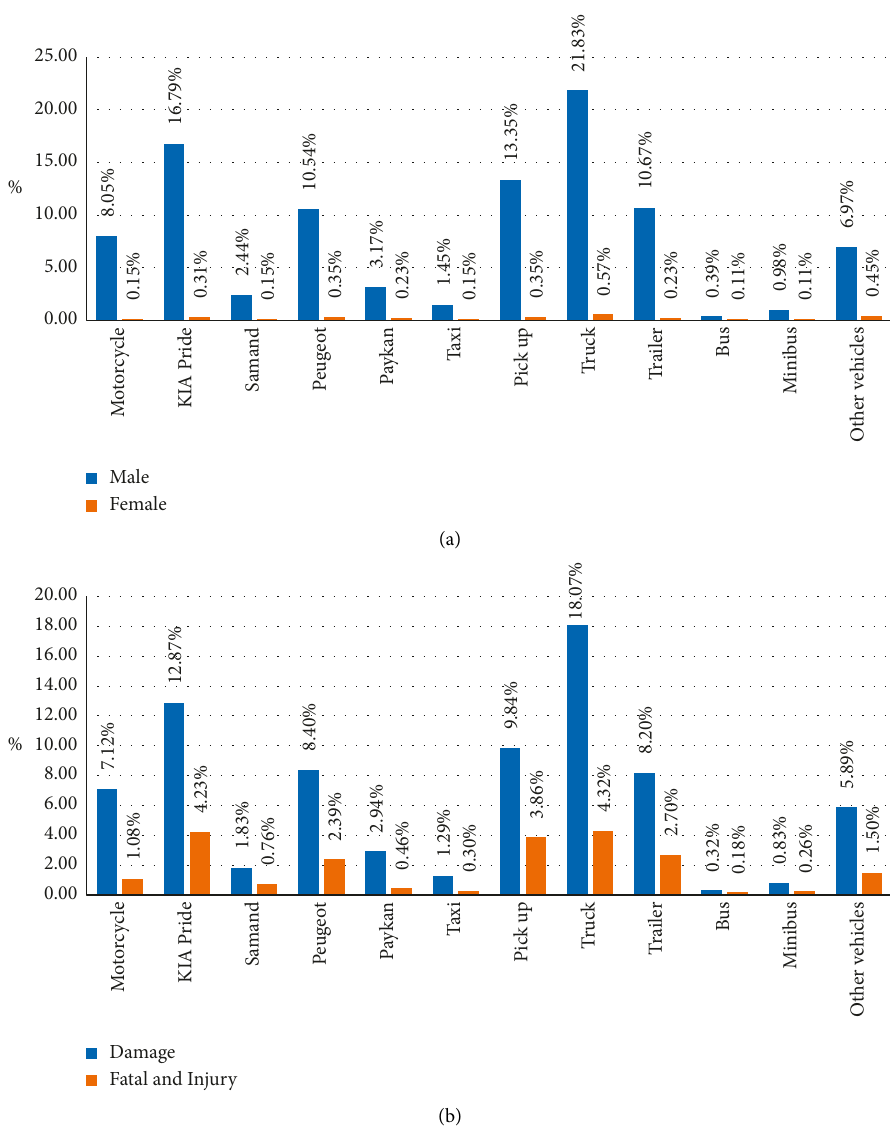
Figure 7: Statistics of vehicle accidents based on vehicle type: (a) gender of the driver and (b) severity of Table 7 represents the components matrix, which in- cludes nine variables in eight factors extracted. Once these factors have no correlation with each other, these factors are the same correlation coefficients between variables in fac- tors. Therefore, the closer the absolute value is to 1, the greater the role of the desired factor in the total variance of numbers. In order to decline the difficulty of interpreting nonrotating component loads, the component matrix was rotated. The aim of the rotated component matrix was to create a new condition for factors to make a better inter- pretation. The effect of variables on the severity of accidents is explained in the factor analysis, and the higher the ab- solute value of variables, the more influential the relevant component in the total changes of variables. The results of Table 8 indicated that driver age, vehicle type, and collision type variables were under the first component, and the coefficients of significance between the first component